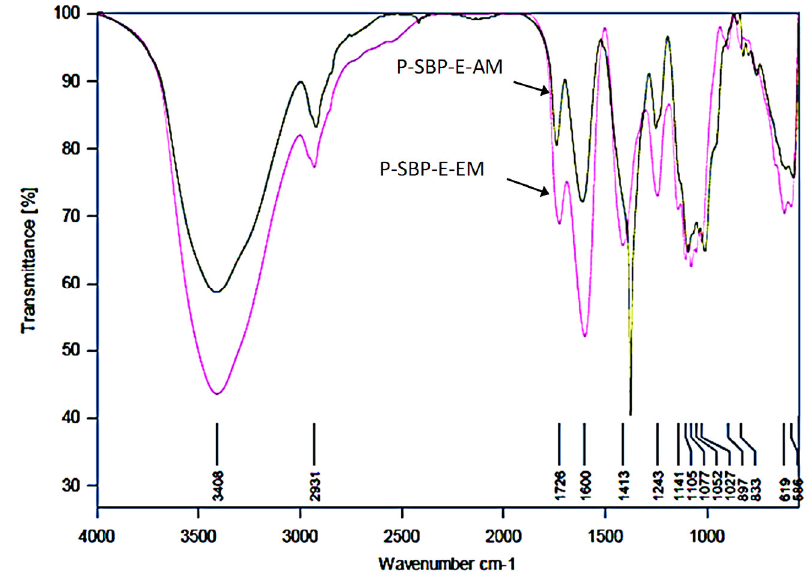
Figure 2. FTIR spectra of sugar beet pulp pectin. P-SBP-E-AM: pectin of sugar beet pulp ensiled, extracted by acid method. P-SBP-E-EM: pectin of sugar beet pulp ensiled, extracted by enzymatic method.